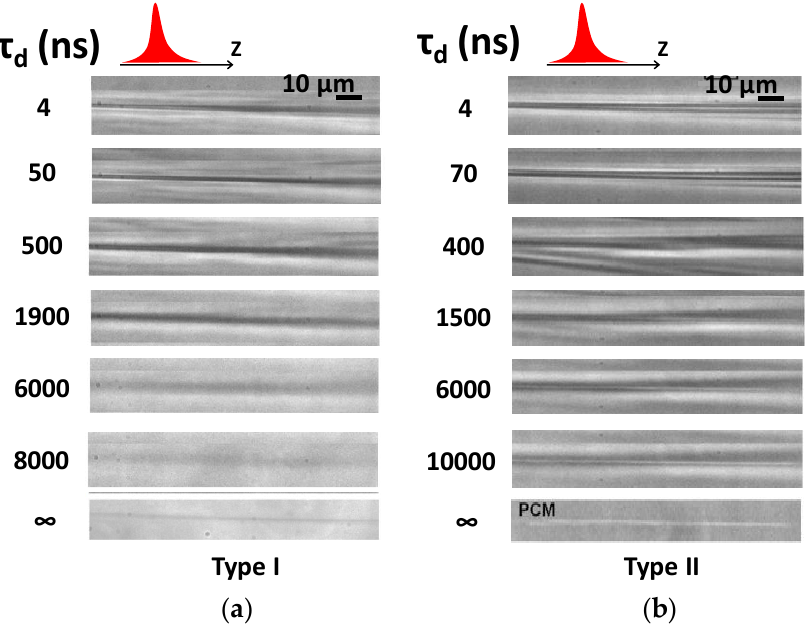
Figure 8. ( a ) Time-resolved sequence of index contrast images corresponding to the appearance of a permanent positive index change (dark colors) induced by a single Bessel laser pulse. The evolution is monitored for a time domain ranging from about 1 ns to about 10 μs, with imaging delays given on the side of each snapshot. Input laser pulse parameters: 15 μJ and 2 ps. The laser beam arrives from the left; ( b ) Multiscale time-resolved sequence of index contrast images corresponding to the appearance of a void-like structure (light colors) induced by a single laser pulse. The evolution is monitored for a time domain ranging from about 1 ns to about 10 μs. Input laser pulse parameters: 20 µ J and 5.5 ps. The laser pulse comes from the left. The measurement is similar to the data reported in Ref.